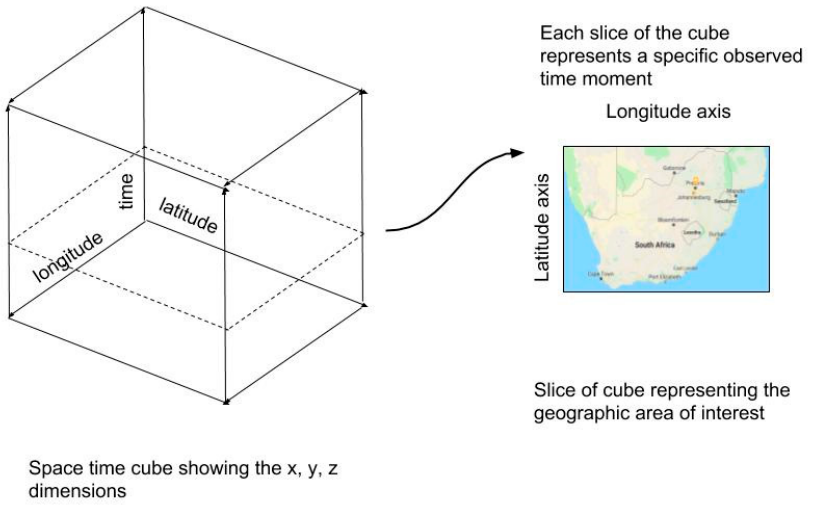
Figure 6. Conceptual illustration of the space time cube.